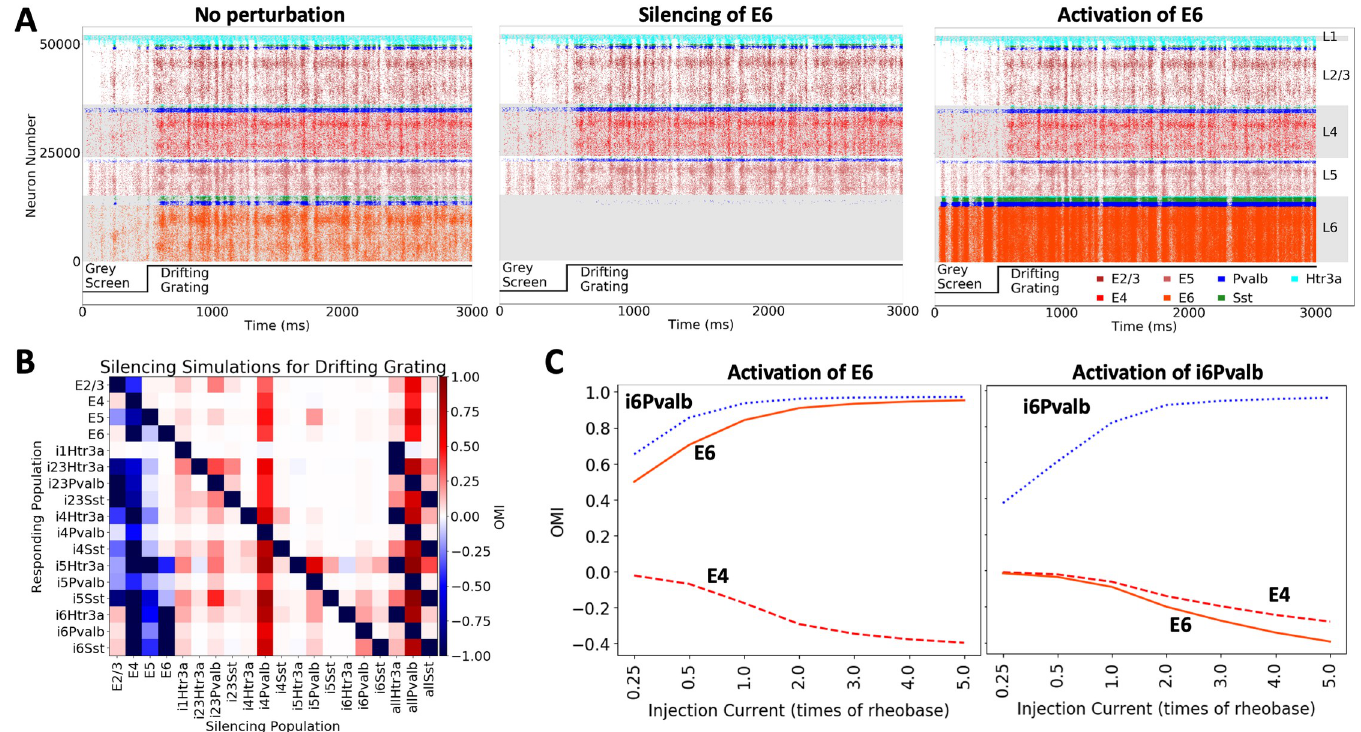
Fig 8. Simulation of optogenetic perturbations using BMTK. The point-neuron version of the V1 model ( Fig 6 ) is used here for illustration. Perturbations are achieved by injecting positive or negative current into cells. (A) Raster plots from 3-second simulations (stimulus: 0.5 s gray followed by 2.5 s of a drifting grating). Simulations without perturbation, with complete silencing of all Layer 6 excitatory cells (E6), and activation of all E6 cells (current equal to 0.5 of the rheobase of each neuron at rest is injected) are illustrated. The perturbation here is applied throughout the course of simulation. (B) Summary of silencing individual cell classes in the V1 model, for the same visual stimulus as in (A). The cell classes listed along the horizontal axis are silenced one by one, and the effect on each cell class (listed along the vertical axis) is characterized using the Optogenetic Modulation Index (OMI; see Main text), averaged over 10 trials and over all cells in the class. The entries “allHtr3a”, “allPvalb”, and “allSst” refer to simulations where, e.g., the Sst class of neurons was silenced in all layers (“allSst”). (C) Activation of Layer 6 excitatory or Pvalb inhibitory neurons, for the same visual stimulus as in (A). Different amplitudes of perturbations are sampled. OMI is computed as in (B), and is shown for 3 select cell classes. Due to inter-laminar projections of Layer 6 Pvalb interneurons to upper layers, activation of either Layer 6 excitatory or Layer 6 inhibitory Pvalb cells leads to the suppression of activity in Layer 4.